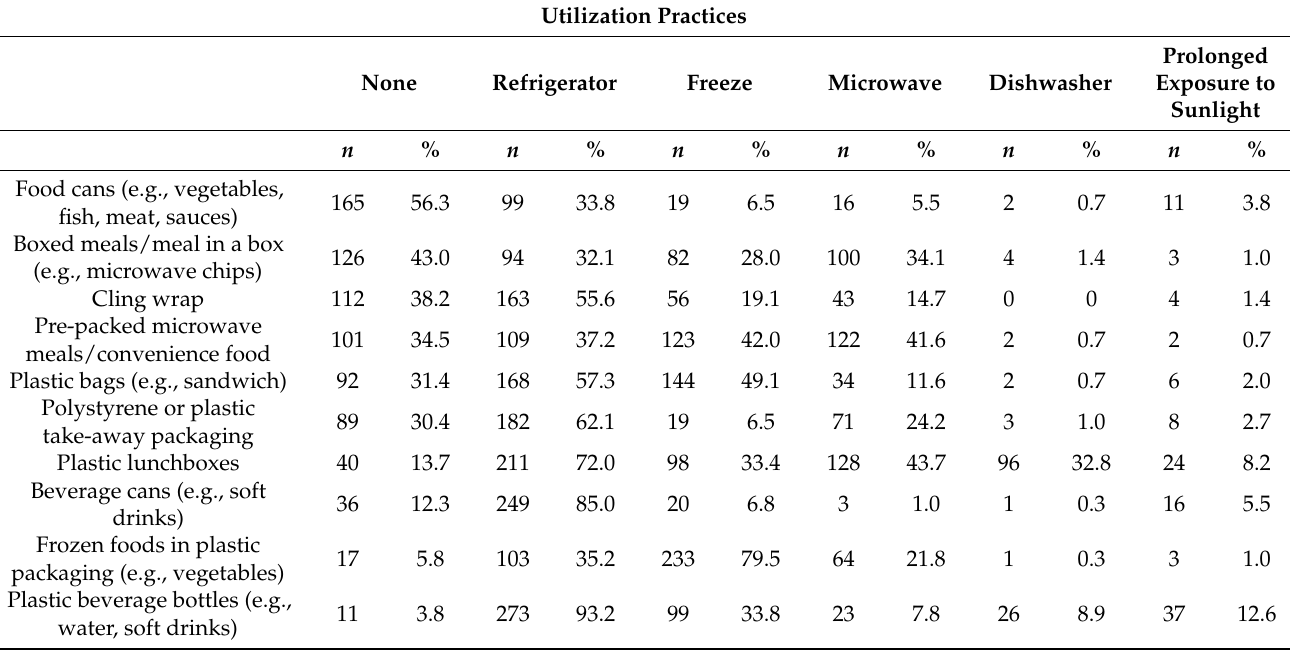
Table 4. Frequencies of participants engaging in different utilization practices of plastic food packaging ( n =